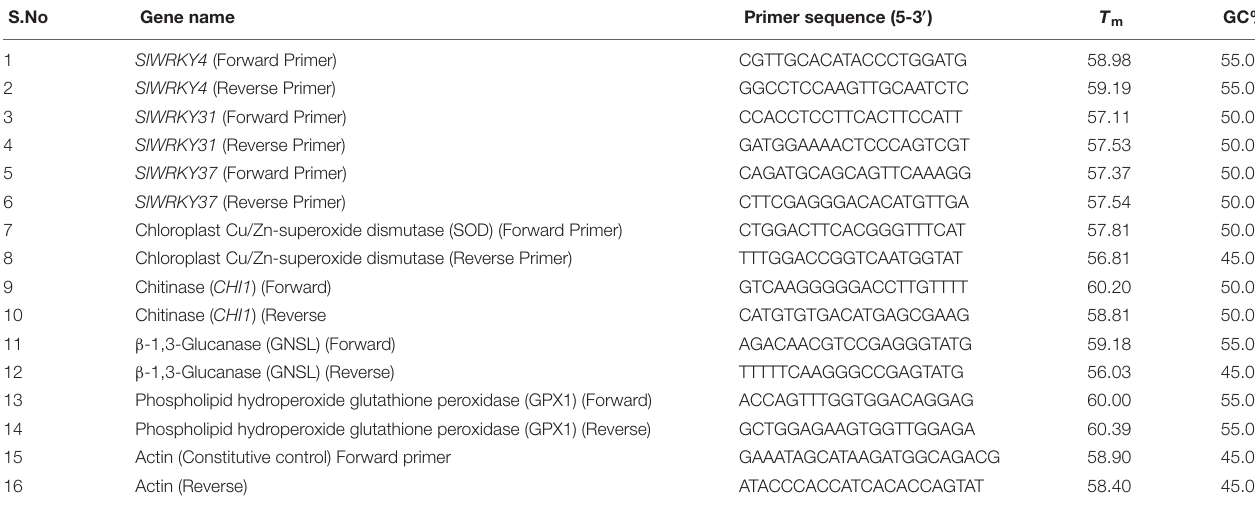
TABLE 1 | List of gene specific primers used for quantitative and semi-quantitative real time PCR studies.